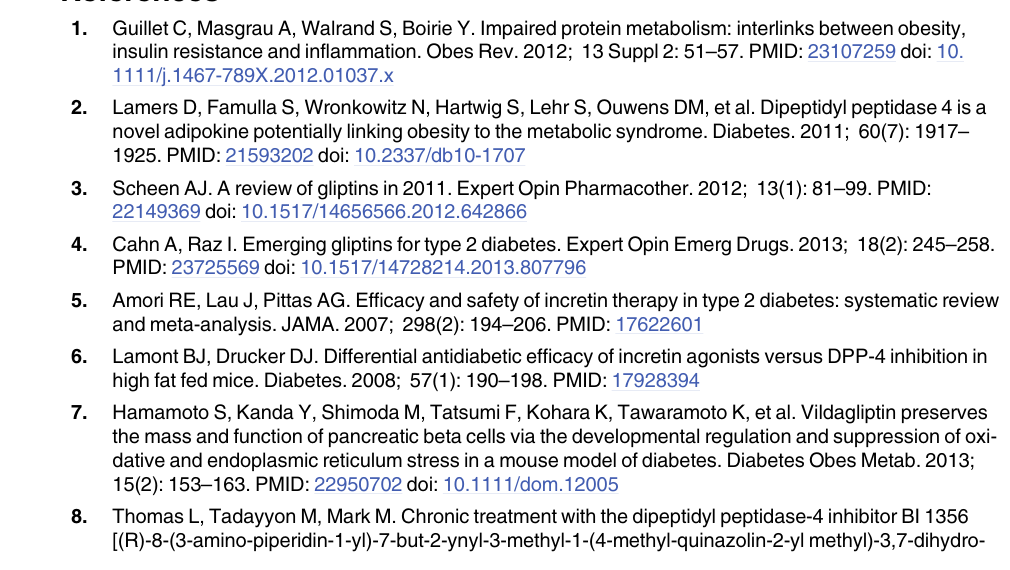
S6 Fig. Effects on gene expression in white adipose tissue after 2-week treatment in HF-DIO mice. S7 Fig. Effects of on adipogenesis and PPAR α / γ activation. S1 Table. Primers and probe for mouse genes used. S2 Table. Body composition changes in Study 2 after 2-week